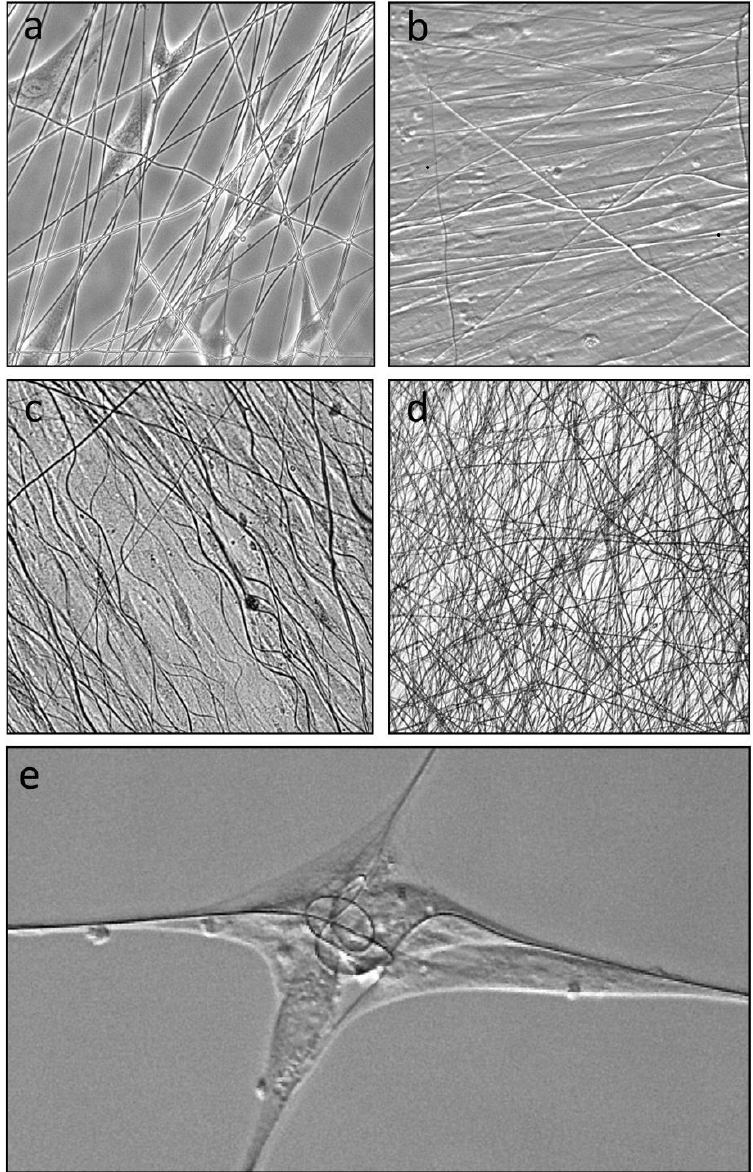
Figure 2. ( a ) Electrospun PLG fibers (1–2 µ m diameter) of a single layer frame seeded with dermal fibroblasts, on one side, and imaged with phase contrast at 24 h showing attachment and alignment of scattered cells along fibers. ( b ) Single layer frame on day 4 showing confluent sheets of fibroblasts attached to and supported by fibers. Phase image shows cells aligned (horizontally) in the same direction as the majority of fibers. ( c ) Brightfield image of fibers and cells on a single layer frame at day 7. Fibers are aligned in the same direction as cells. Wavy fiber profiles indicate removal of tension on individual fibers. ( d ) Brightfield image of three layers of stacked layer frames, cultured for 7 days, showing alternating orientations of fiber meshes in the different layers. ( e ) Cluster of four cells, on day 2, attached to two crossed fibers showing fibers drawn into coils by extended cells.